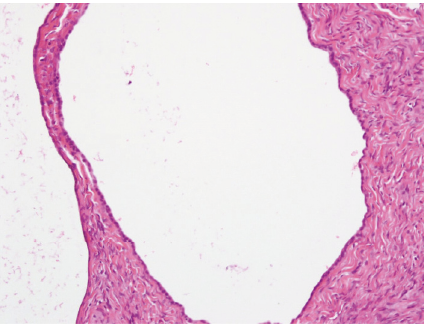
Figure 2: Pathology of the right ovary shows benign serous